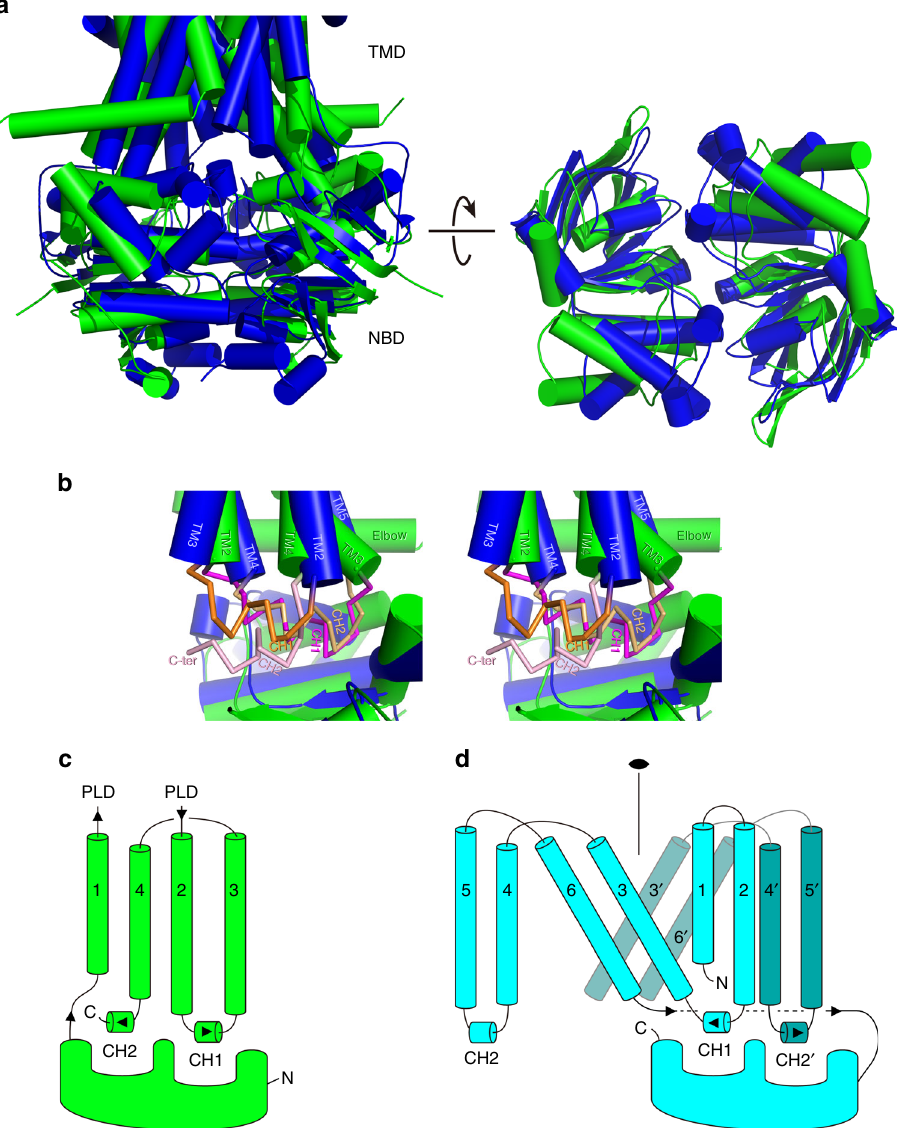
Fig. 5 Comparison of NBDs and their interactions with coupling helices between MacB and the other type-I ABC exporter. a Superimposition of NBDs from MacB and Sav1866 dimer. MacB NBDs (in green) and Sav1866 NBDs (PDB accession code: 2HYD; in blue) 9 are shown in two orientations, rotated by 90° around a parallel axis to the membrane plane, allowing views from (left) the membrane plane and (right) cytoplasm. b Monomeric NBD views from the membrane plane are superimposed and shown in stereo-view. MacB and Sav1866 (PDB accession code: 2ONJ) 60 TMs, and elbow and coupling helices, are labelled individually. For NBD and TMD, helices are shown in cylinder representation and CHs are shown in backbone tracing for clarity of presentation. CHs of MacB and Sav1866 are coloured in pink and orange, respectively, and CH1s and CH2s are shown in dark and pale colours, respectively. Sav1866 CH2 is in proximity to MacB CH1, whereas MacB CH2 is close to Sav1866 CH1. c , d Topological comparison of CHs and connecting TMs between MacB and other type-I exporters. c Topological diagram of MacB monomer coloured green and ( d ) type-I exporter monomer coloured cyan. Neighbouring monomer in the functional dimer in type-I exporter is coloured in dark cyan. Twofold symmetry axis is also